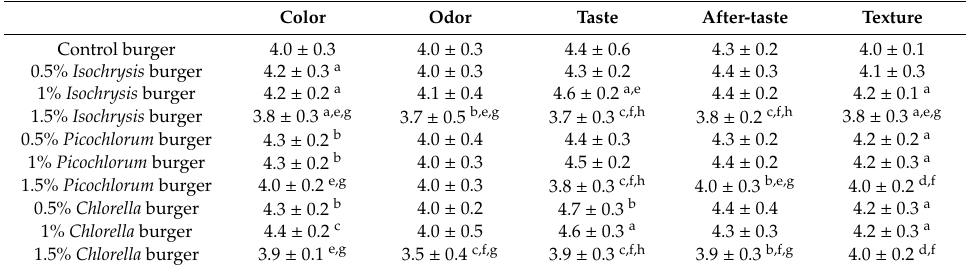
Table 1. Mean scores of tasting panelists (n = 32) for sensory properties of control and microalgae-fortified (0.5, 1 and 1.5%) burgers after production.